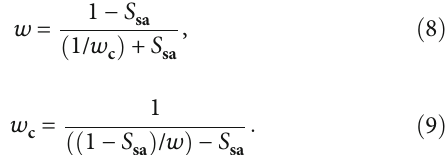
Figure 2: Calculation model of deep-sea